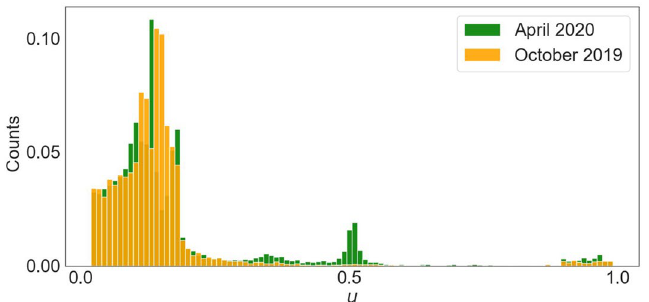
Figure 5. Distribution of the concentrations u i (normalized to 1) for the Twitter network from October 2019 (orange) and April 2020 (green) for a r = 30% of the initial accounts in the state 1 with a 10% of noise ( A = 0.0001, B = 0.01, g = 0.0001, × 0 = 0.01, d =